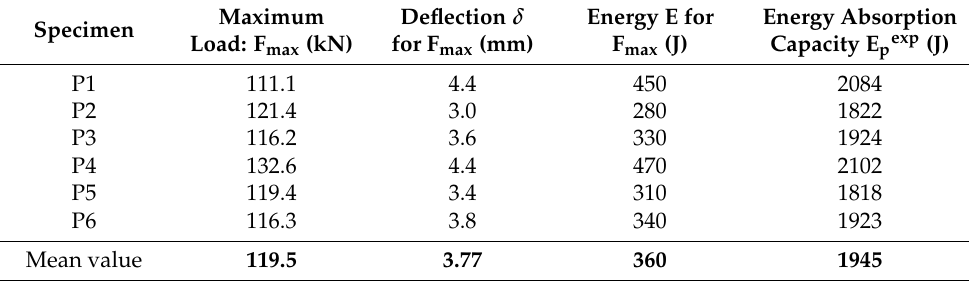
Table 2. Test results for square plates made of fiber composite.